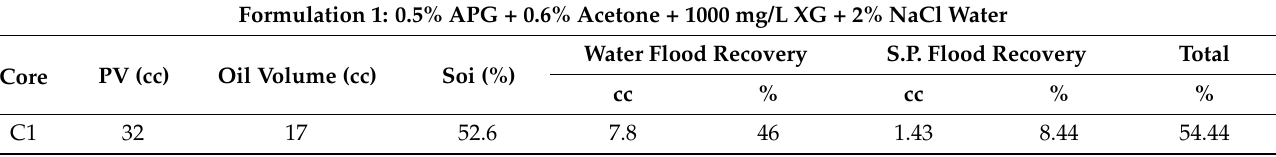
Table 6. Flood results for acetone, APG 264, and Xanthan gum